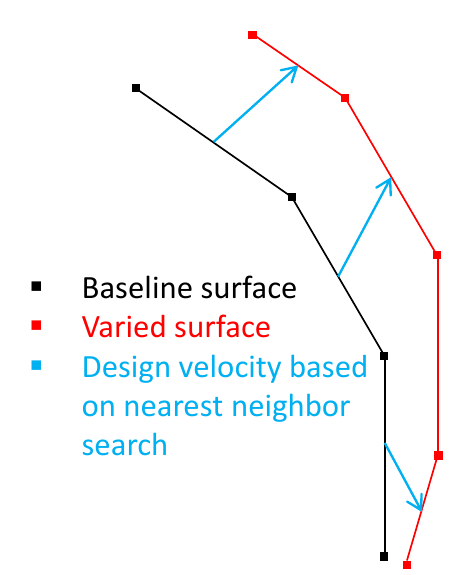
Figure 12. Design velocity